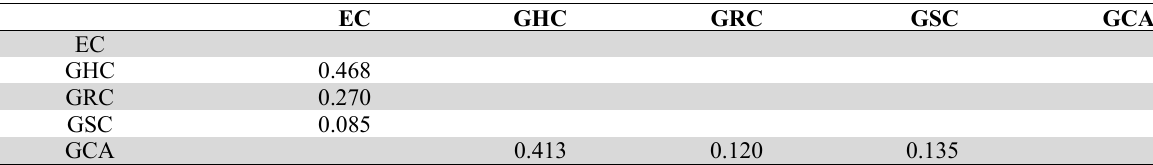
Effect size test